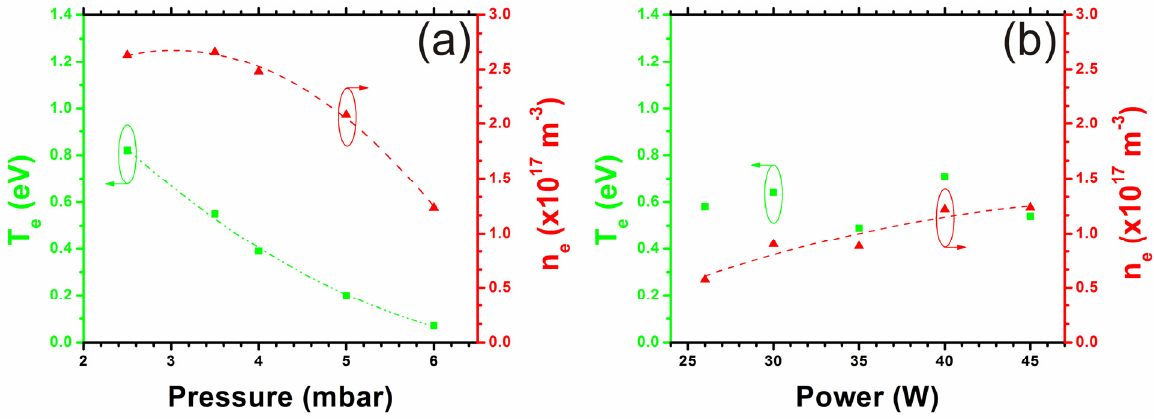
Figure 3. Pressure dependence variation in ( a ) electron density and electron temperature with reactor pressure. Functional fits as shown. (Typical plasma conditions: 45 W/550 V, 700 °C, 4:1 NH :C H ). Functional fits as indicated; ( b ) Power dependence variation in 3 2 2 electron density and electron temperature with power. (Typical plasma conditions: 700 °C,